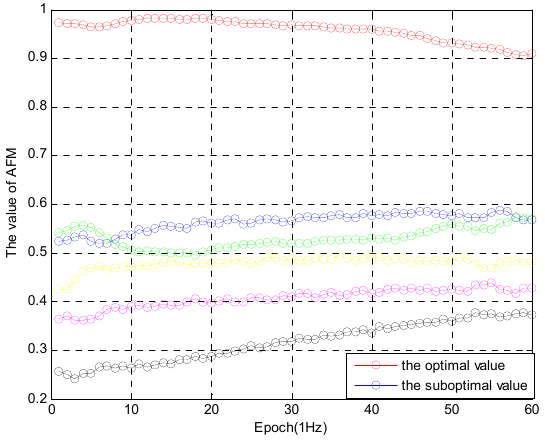
Figure 7. The value ( k W ) of AFM.